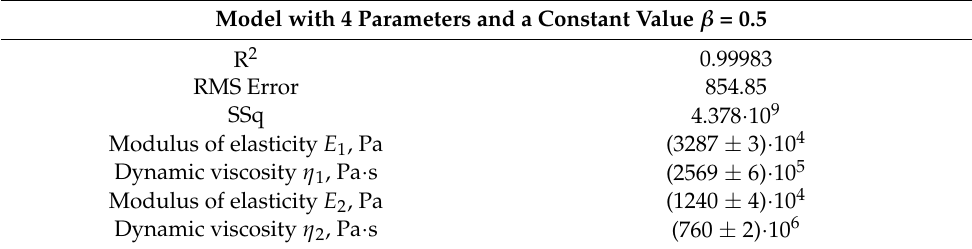
Table 7 matches values of parameters calculated by using the model described by Equation (5) with R 2 , RMS Error and SSq statistical values for exemplary, unaged asphalt binder with a 4.5% SBS copolymer. Table 7. Values of parameters in a generalized Maxwell model described with Equation (5) for unaged asphalt binder containing 4.5% SBS.